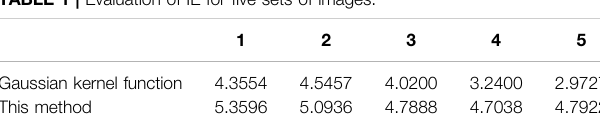
TABLE 1 | Evaluation of IE for fi ve sets of images.